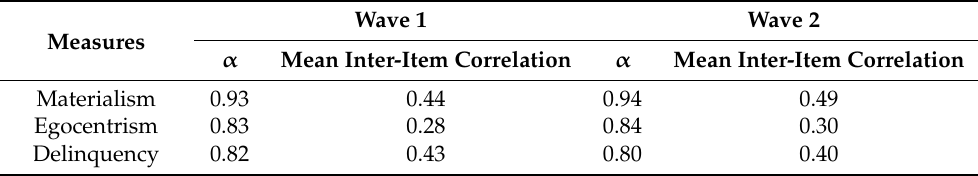
Table 2. Reliability of